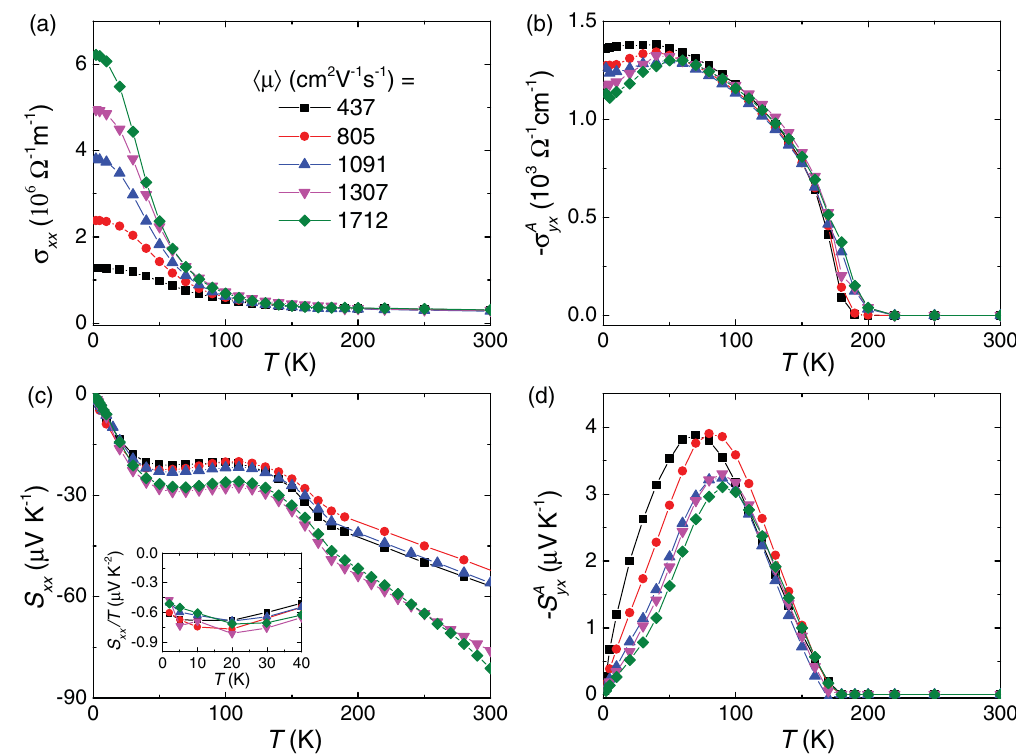
FIG. 5. Four different transport coefficients and disorder. Temperature dependence of (a) longitudinal conductivity, (b) anomalous Hall conductivity, (c) the Seebeck coefficient, and (d) the anomalous Nernst coefficient in the five samples. Note the strong variation of longitudinal conductivity and the anomalous Nernst coefficient with disorder. The anomalous Hall conductivity shows a mild variation at low temperature. As seen in the inset, the low-temperature slope of the Seebeck coefficient does not show any significant change implying that any change in the position of chemical potential is